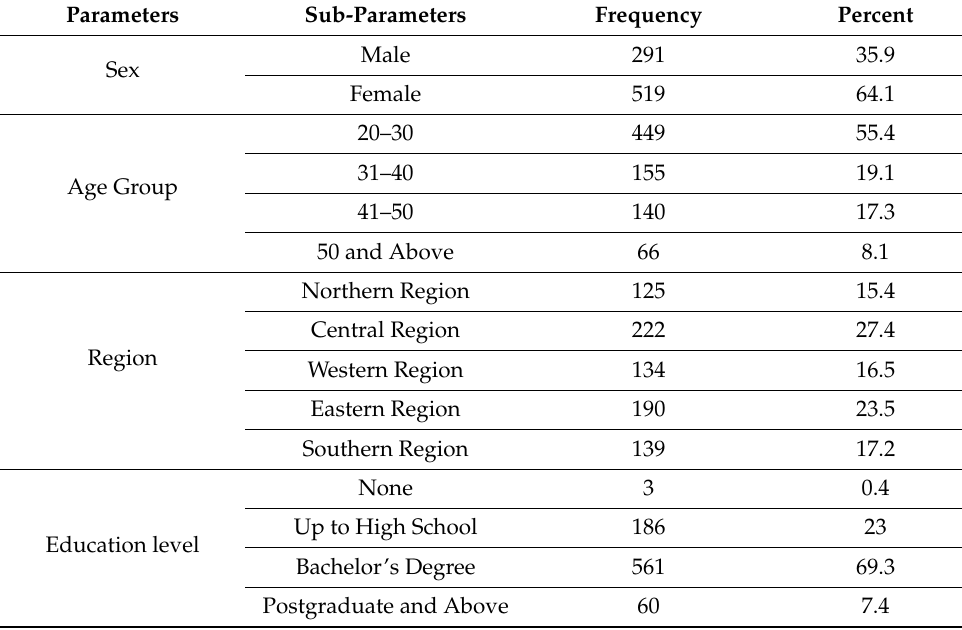
Table 1. Distribution of study population, according to gender, age, region, and education